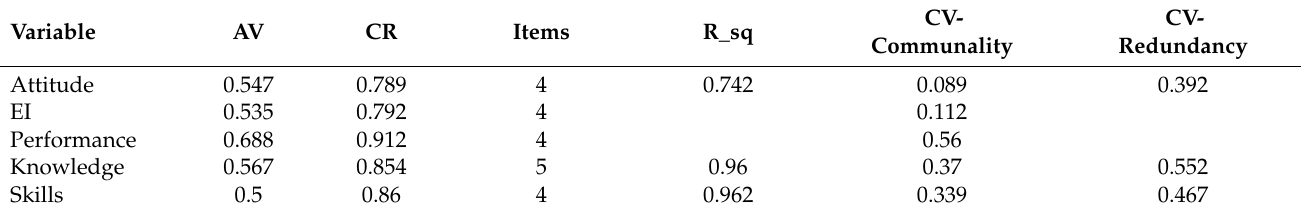
Table 4. Results of Reliability and Validity